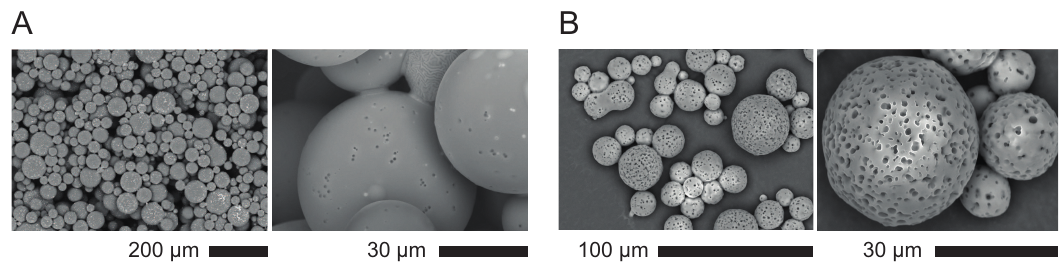
Figure 7. Batch particles produced by manual emulsification followed by UV-curing. ( A ) low density of calcite (before and after removal of calcite, left and right respectively where the calcite particles show as bright spots); ( B ) high density of calcite after its removal.